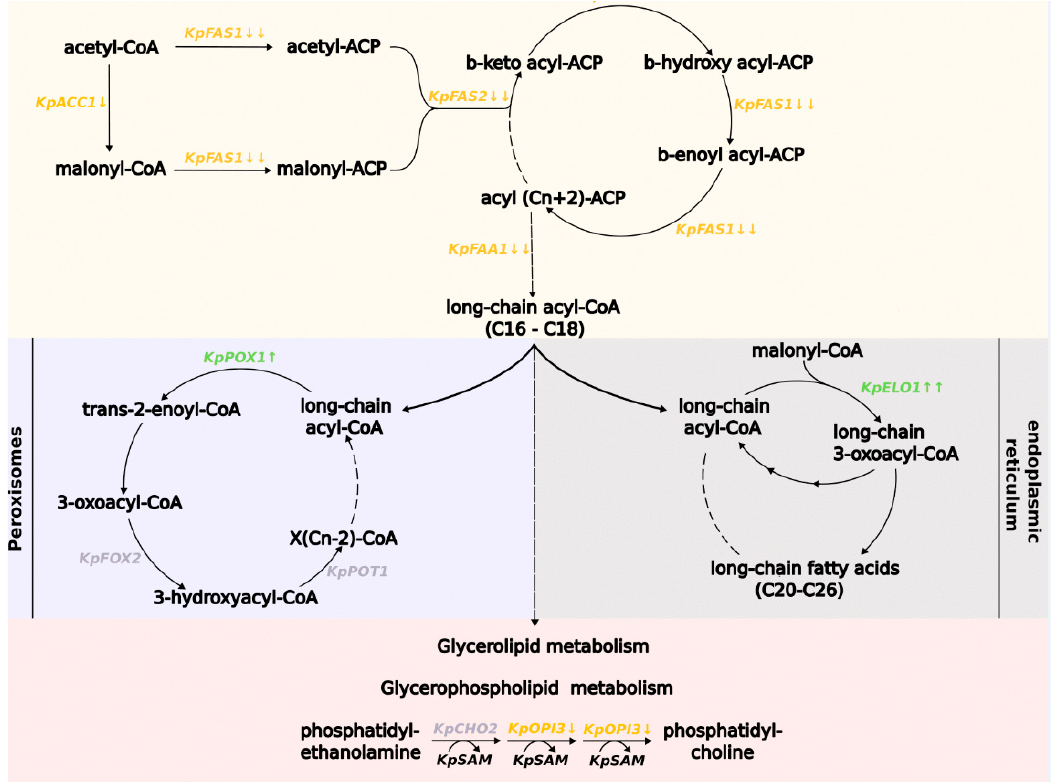
Figure 3. Scheme of the proposed fatty acid metabolism pathways in K. phaffii cells (based on data for S. cerevisiae [61,63]). Genes are placed near the reactions catalyzed by the corresponding proteins. Genes that are repressed in media with methionine are marked in orange. Genes that are activated in media with methionine are marked in green. Genes that do not change their expression are marked in grey. The number of arrows represents values of the log2FoldChange parameter: one arrow 0.5 < log2FoldChange < 1; two arrows 1 < log2FoldChange < 2; three arrows 2 < log2FoldChange.